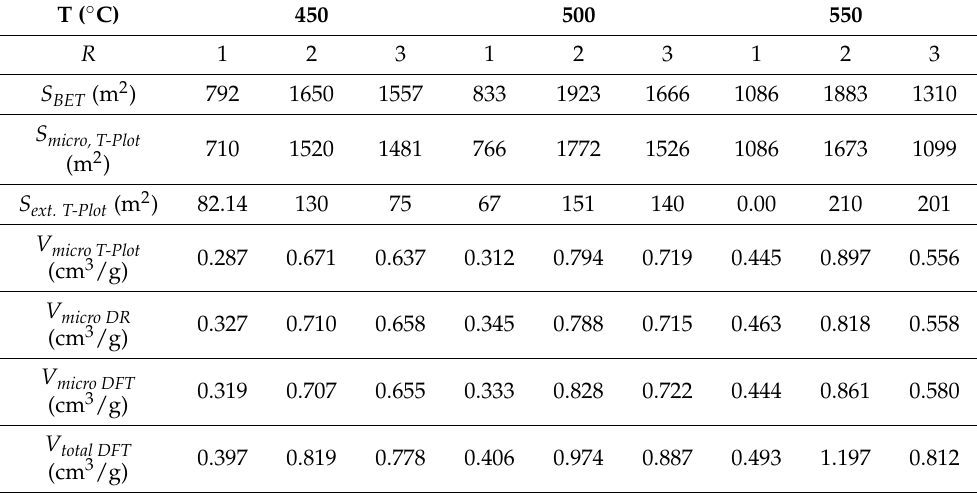
Table 1. The results of the analysis of a microporous structure of nitrogen-doped activated carbons, based on nitrogen adsorption isotherms, determined using the BET [31], T-plot and DR methods. T ( ◦ C) 450